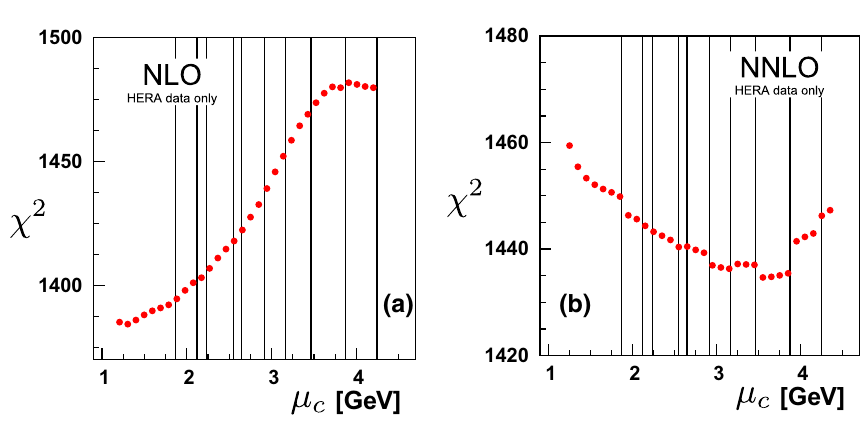
Fig. 5 χ 2 vs. the charm matching scale μ c at a NLO and b NNLO for all data sets. The bin boundaries for the HERA data set “HERA1+2 NCep 920” are indicated by the vertical